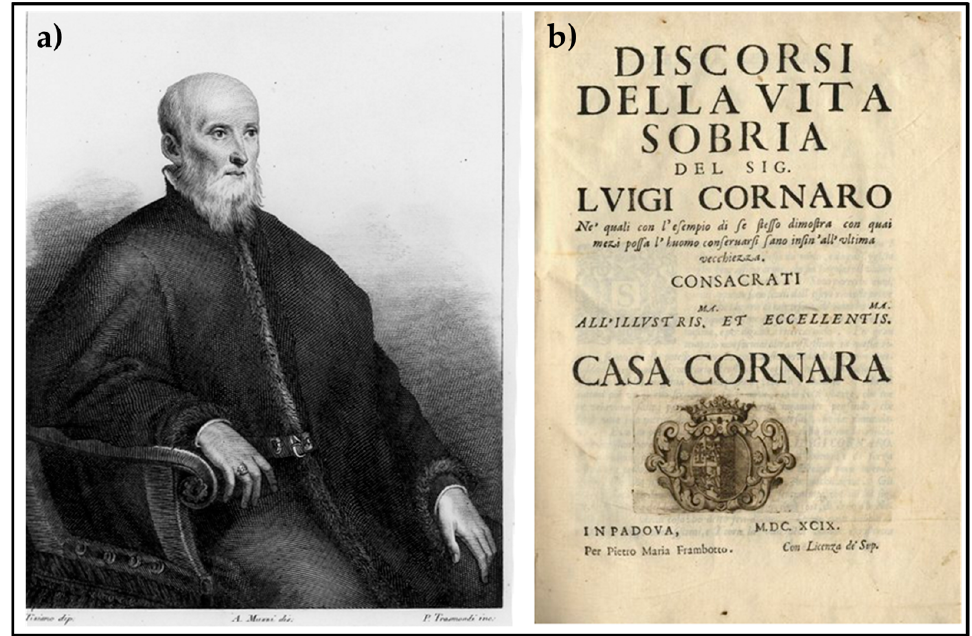
Figure 1. ( a ) Portrait of Alvise/Luigi Cornaro by Tintoretto, General Catalogue of Italian Cultural Heritage. ( b ) Front page of “ Discorsi Della Vita Sobria ”.